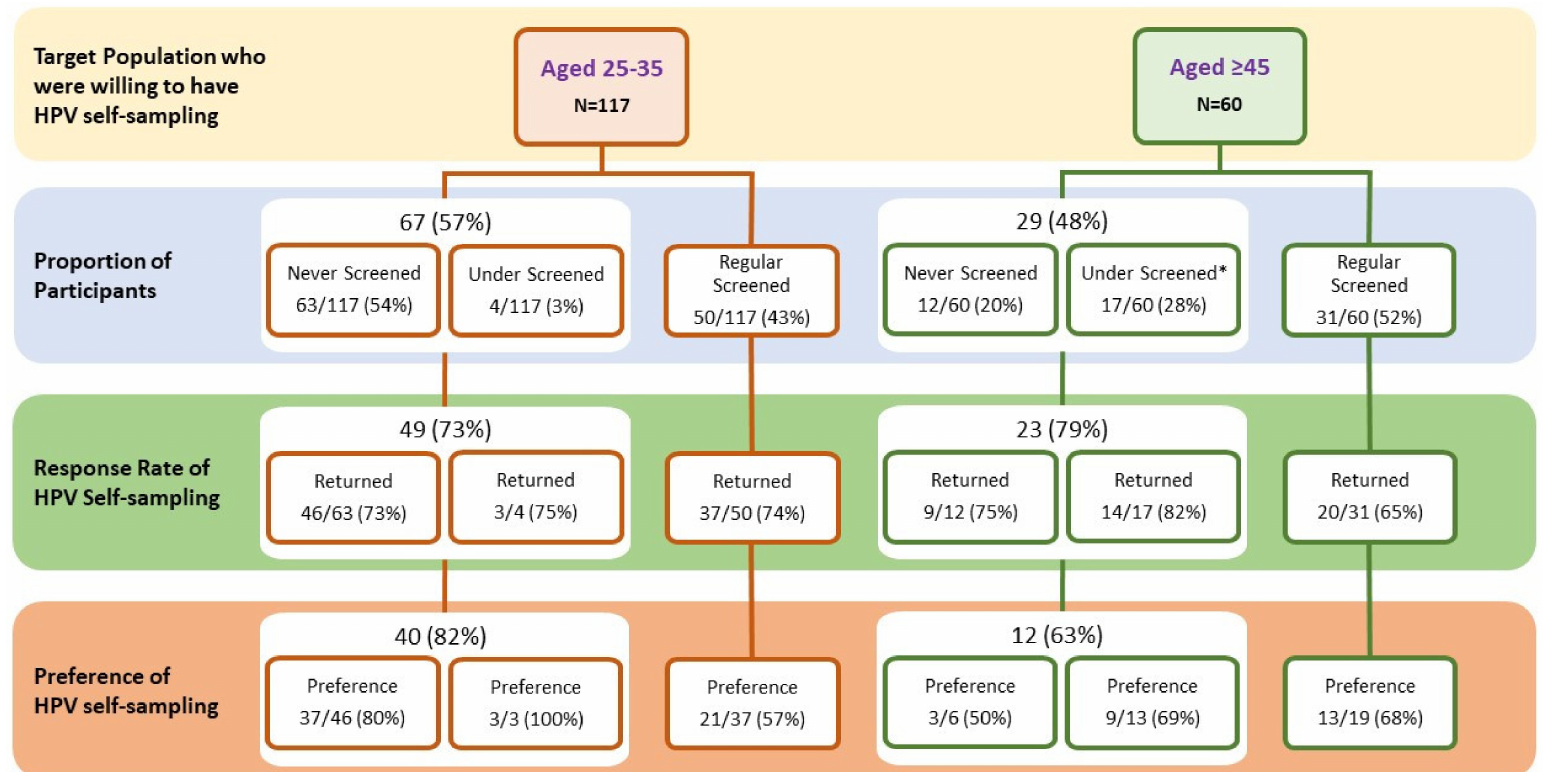
Figure 1. Response rate of HPV self-sampling and preference for HPV self-sampling by cervical cancer screening behaviour of participants. “Under Screened” was defined as not having Pap smear screening in the past 3 years for those aged 25–35, while it was defined as not having Pap smear screening in the past 5 years for those aged ≥ 45. “Never screening” was defined as never having the Pap smear before. “Response rate of HPV self-sampling” means the proportions of returning HPV specimens after performing HPV self-sampling. Preference for HPV self-sampling means willingness to use HPV self-sampling as an alternative primary screening for cervical cancer in the future after trying HPV self-sampling. A few numbers were not added up to total due to missing